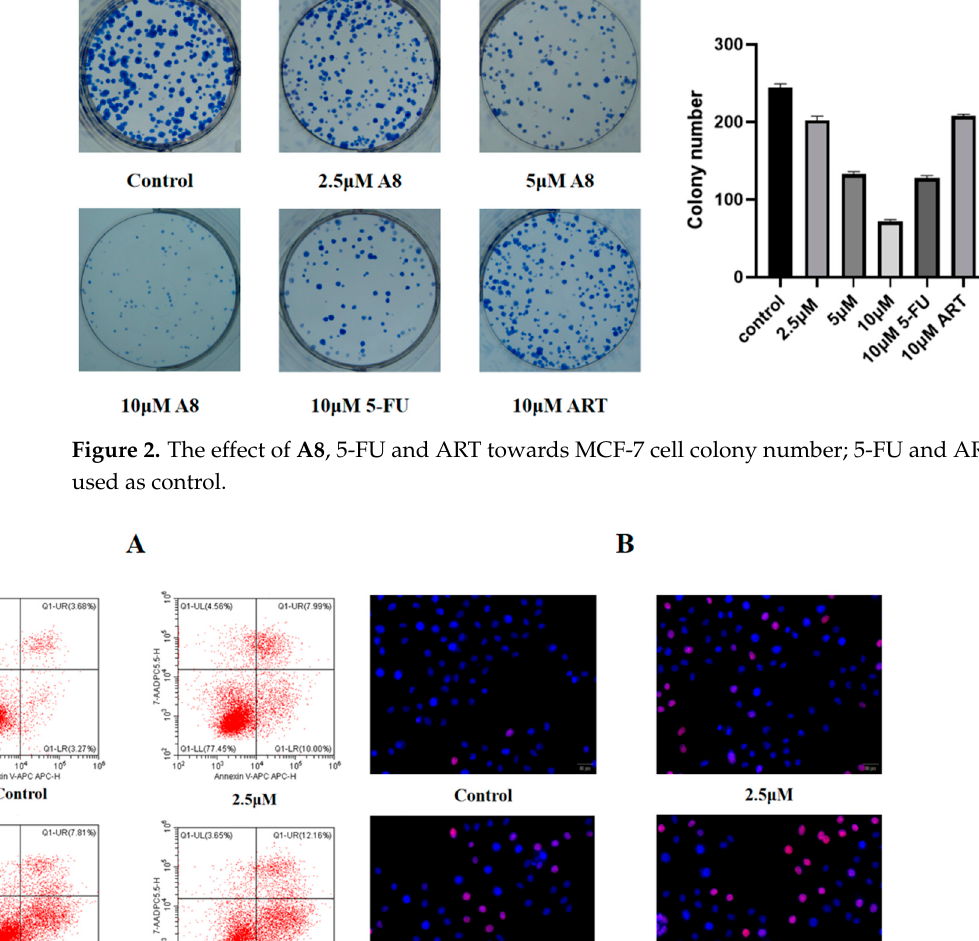
Figure 2. The effect of A8 , 5-FU and ART towards MCF-7 cell colony number; 5-FU and ART were used as control.